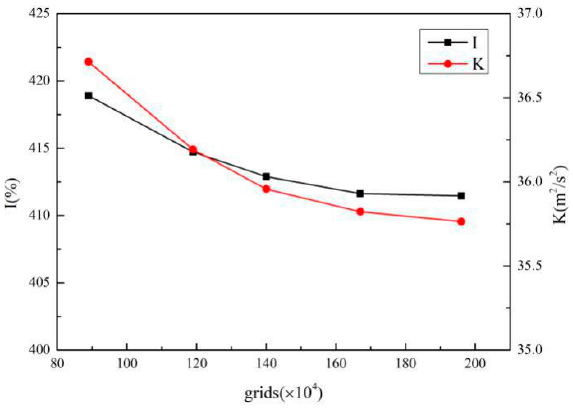
Figure 3. The weighted average turbulent kinetic energy ( K ) and weighted average turbulence intensity ( I ) at z = 1.5 m cross-section under different grids.